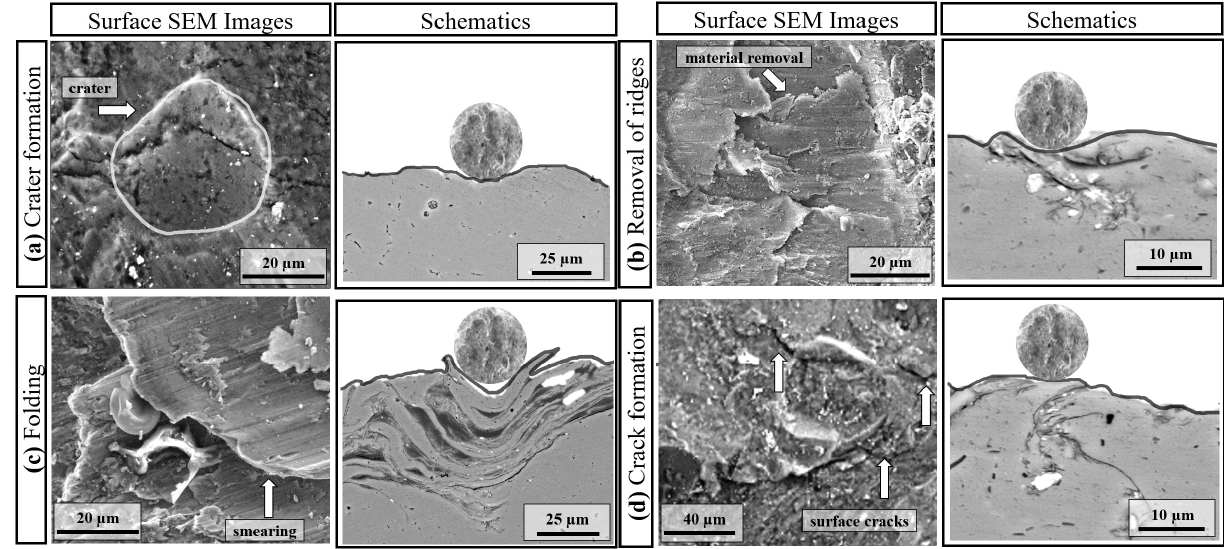
Figure 9. Schematics of deformation mechanisms; ( a – d ) showing the interaction of the shots with the surface under different parameters, as observed by SEM analysis.